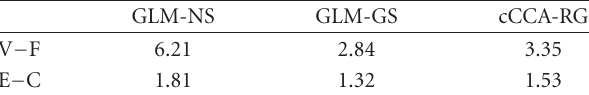
Table 2: Ratio of activations in gray matter and outside of gray matter for di ff erent analysis methods. The number in the table is the ratio of the number of voxels detected in gray matter and the number of voxels detected outside of gray matter. Note that the GLM-NS has the highest value because there is no smoothing involved. Compared to fixed Gaussian spatial smoothing (GLM- GS), cCCA-RG yields higher ratios demonstrating less blurring and better confinement to gray matter. GLM-NS GLM-GS cCCA-RG V − F 6.21 2.84 3.35 E − C 1.81 1.32